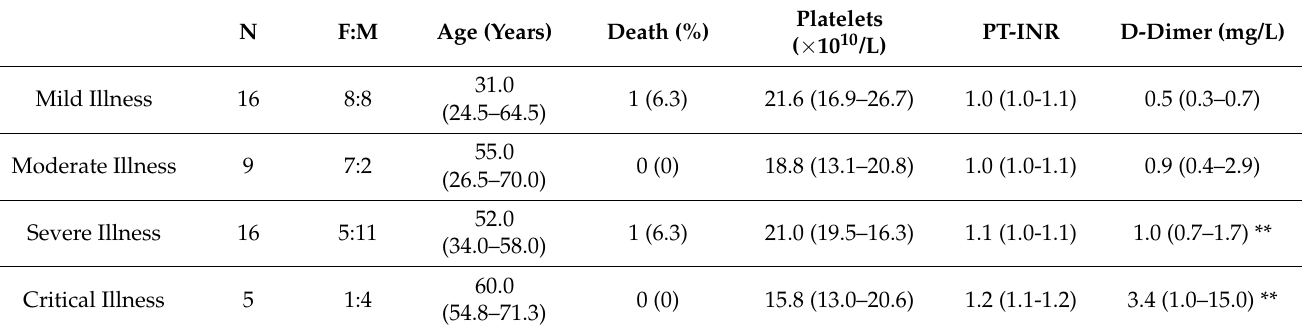
Table 2. Patients with COVID-19